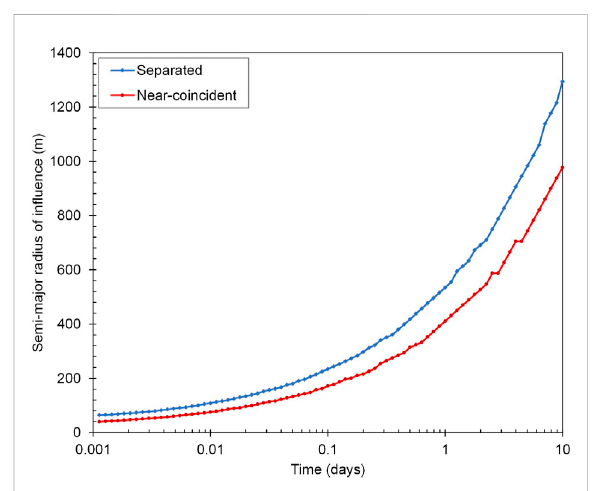
FIGURE 15 Radiusofsemi-majoraxisofellipseofin fl uenceforseparated and near-coincident